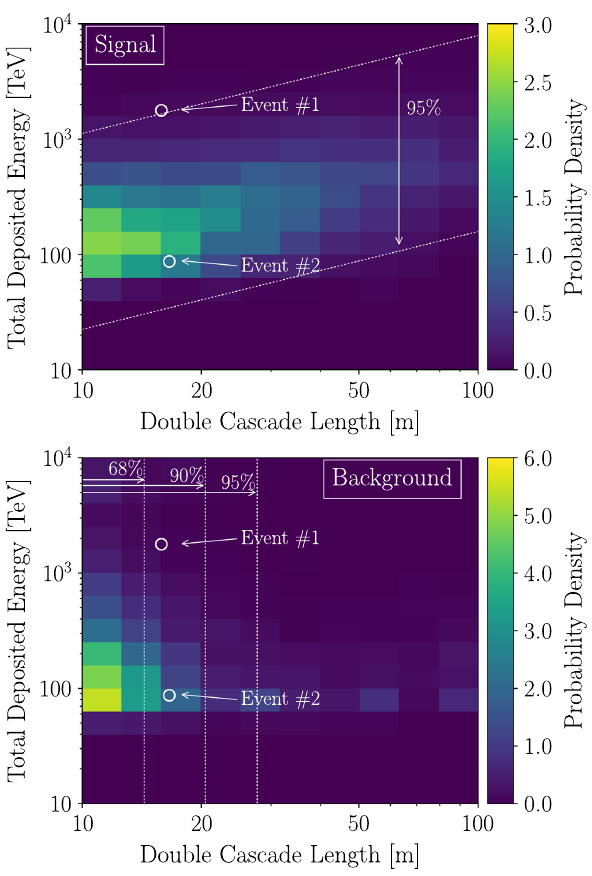
Fig. 2 Two-dimensionalMCPDFsshowingtotalreconstructedenergy versus reconstructed double-cascade length for the double-cascade sub- sample with data points, using the best fit to the atmospheric and astro- physical components with the flavor composition of astrophysical neu- trinos fixed to 1:1:1 [19]. In the signal ( ν τ -induced double-cascade events) histogram (top), the region containing 95% of the expected sig- nal is indicated with white dotted lines. In the background (all remain- ing events) histogram (bottom), the white vertical dotted lines mark the regions containing 68% , 90% , and 95% of the single-cascade induced background. In both histograms the two tau neutrino candidates are overlaid as white